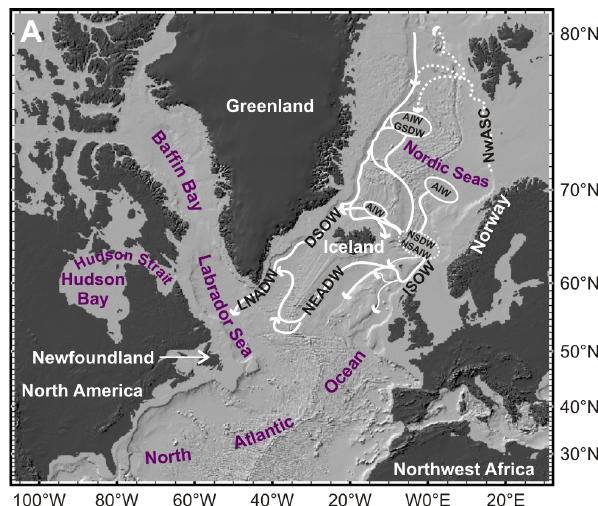
Figure 2b. Core sites mentioned in the text in relation to the modern convection sites in the Nordic Seas and the modern deep-current system in the northern North Atlantic Ocean and the Nordic Seas (same as in Fig. 2a to the left) (Hansen and Østerhus, 2000). As indicated, winter convection was unlikely to have occurred in the Labrador Sea before 7000years BP (Hillaire-Marcel et al., 2007). LIS: Laurentide Ice Sheet (marked by the dotted white line). Lake Agassiz–Ojibway is also shown (Teller et al.,